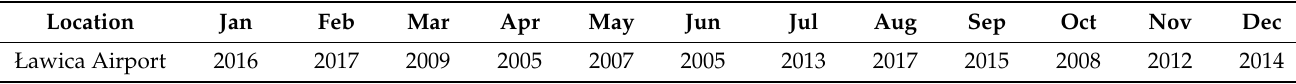
Table 2. Selected years of each month in the Poznan Typical Meteorological Year for the period of 2004–2018. Location Jan Feb Mar Apr May Jun Ławica